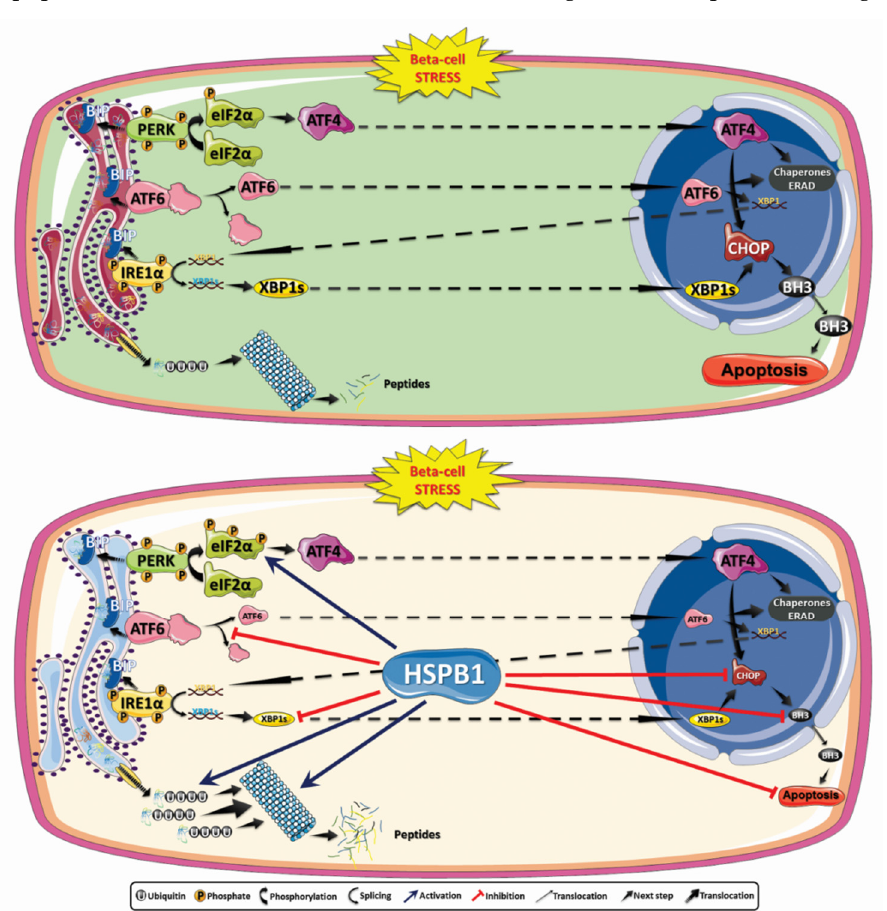
Figure 6. HSPB1 inhibits ER stress-induced cell death by modulating UPR, protein ubiquitination, and protein degradation rate via the proteasome. The UPR is activated by stress to restore cellular homeostasis. ( Upper panel ) Under conditions of intense and prolonged stress, UPR activates mechanisms of cell death by increasing the expression of proapoptotic proteins such as CHOP and proteins of the BH3-only family. ( Bottom panel ) HSPB1 overexpression in mouse pancreatic islets promotes increased PERK phosphorylation, as well as attenuation of eIF2 α phosphorylation, ATF4 and cleaved ATF6 levels, the IRE1 α pathway, and expression of proapoptotic mediators CHOP and BIM. This process, associated with an increase in protein degradation by the ubiquitin-proteasome system, allows keeping cellular proteostasis under control, thus avoiding the activation of proapoptotic signaling pathways.